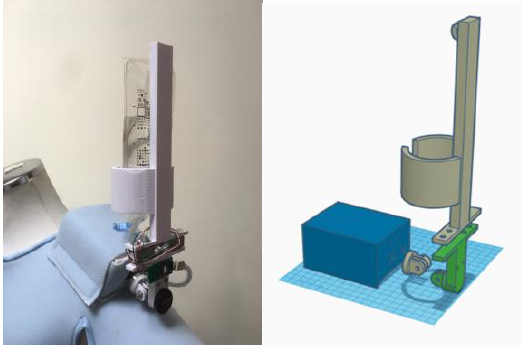
Figure 24. The left-shoulder module.